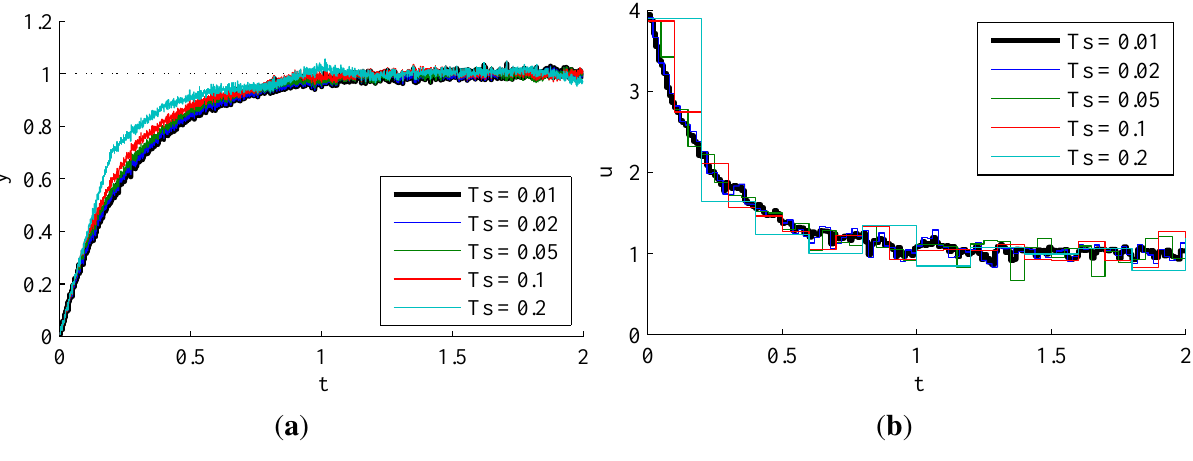
= 0 . 0001. Observer pole placement: k noise